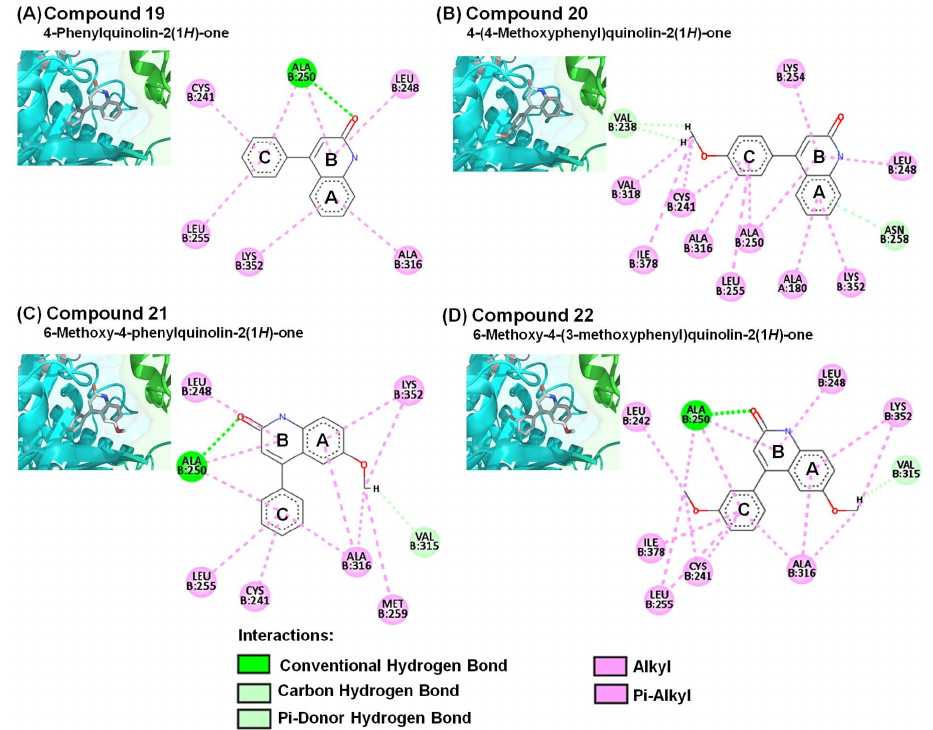
Figure 5. Close-up of ( A ) 19 , ( B ) 20 , ( C ) 21, and ( D ) 22 within the colchicine-binding site of the αβ -tubulin shown along with their corresponding 2D interaction plots.